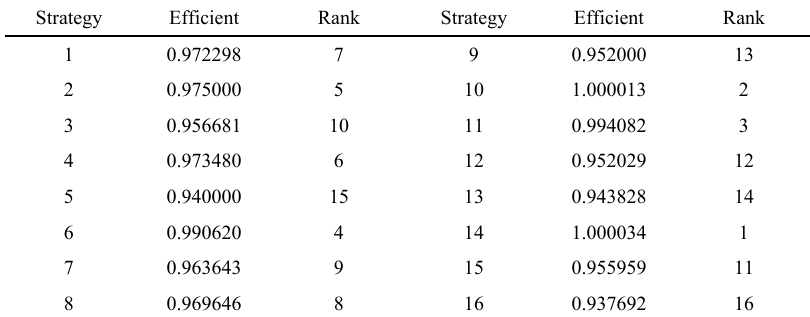
Table 7: Efficiencies and rank orders